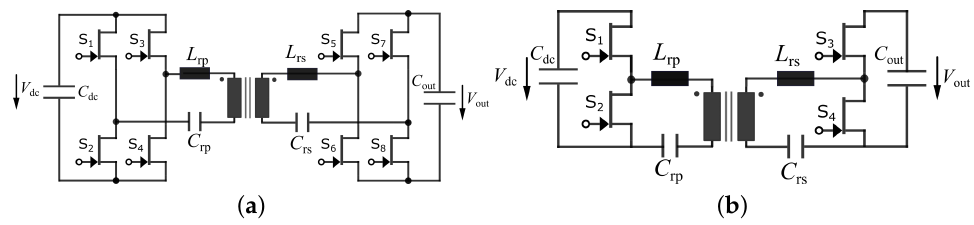
Figure 21. ( a ) Full-bridge and ( b ) half-bridge CLLC (derived from [153]) converter